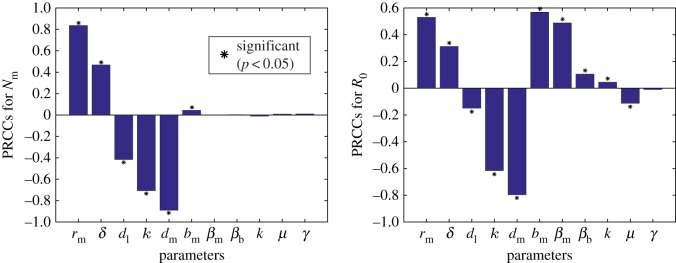
Performance of LHS/PRCC on the model (2.2). Parameters with a PRCC significantly (p<0.05) different from zero are indicated with (*). (a) PRCCs between input parameters and the outcome variable Nm and (b) PRCCs between input parameters and the outcome variable R0.